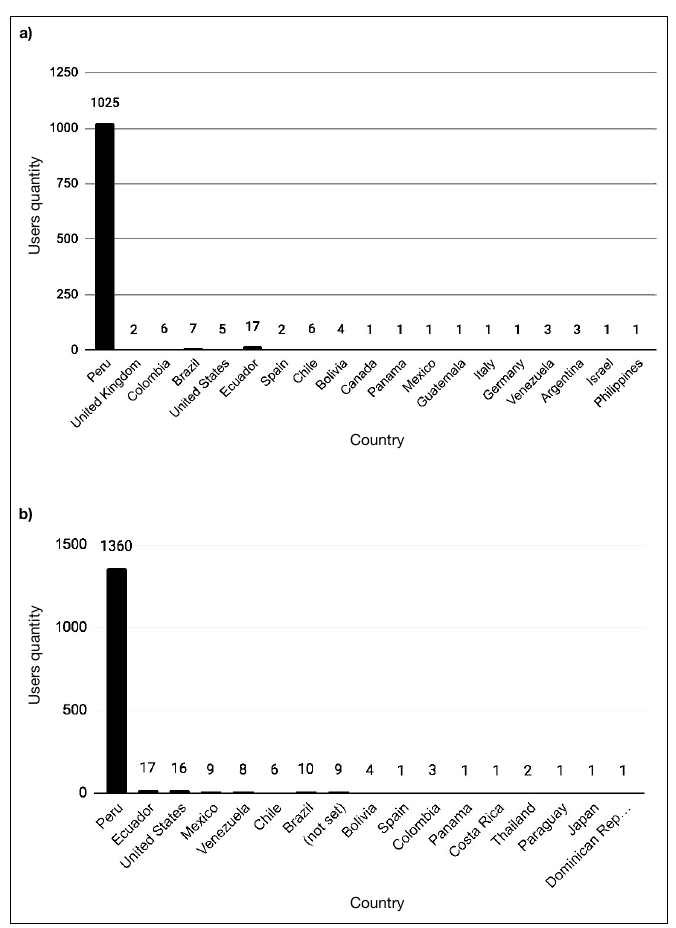
Figure 2. Demographic description: ( a ) pre-test; and ( b )